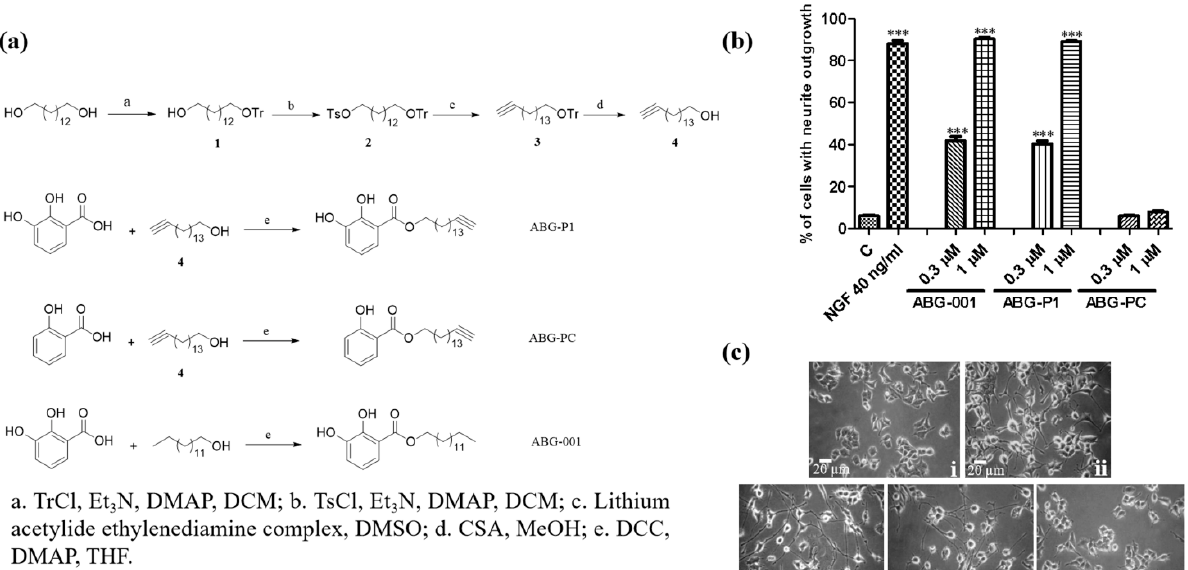
Figure 2. Synthesis of probes and their neurogenesis effect in PC12 cells. ( a ) Synthesis scheme and chemical structures of ABG-P1, ABG-PC, and ABG-001. ( b ) Percentage of PC12 cells with neurite outgrowth after treatment with ABG-001, ABG-P1, and ABG-PC. ( c ) Morphological changes in PC12 cells under an inverted optical microscope at 48 h after treatment with (i) control (0.5% DMSO); (ii) NGF (40 ng/mL); (iii) ABG-001 (1 µ M); (iv) ABG-P1 (1 µ M); (v) ABG-PC (1 µ M). Scale bar, 20 µ m. Each experiment was repeated thrice. The data were expressed as mean ± SEM. *** indicates significant differences at p < 0.001 compared with the negative